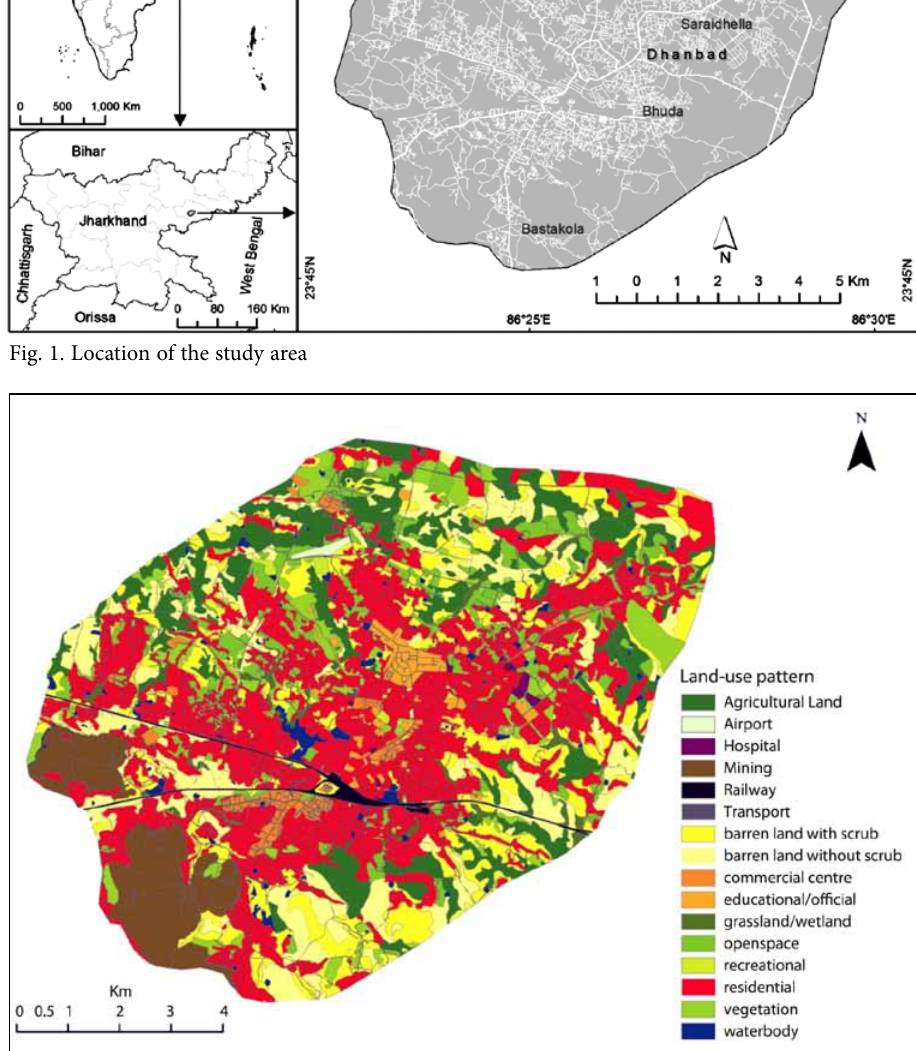
Fig. 2. Land-use of the study